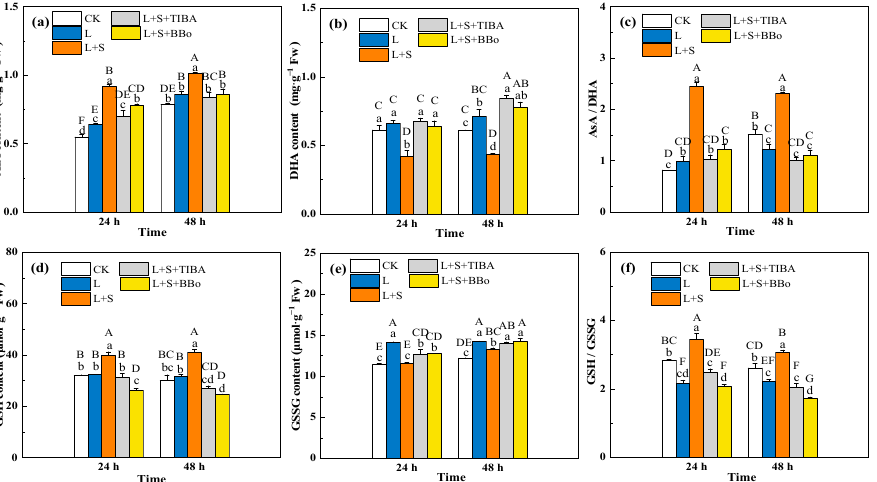
Figure 7. Effects of exogenous sucrose and IAA inhibitors on AsA ( a ), DHA ( b ), AsA/DHA ratio ( c ), GSH ( d ), GSSG ( e ), and GSH/GSSG ratio ( f ) of M. baccata under sub-low temperature. Bars indicate means ± standard error ( n = 3). The lowercase letters represent significant differences between treatments ( p < 0.05). The capital letters represent significant differences between full data ( p < 0.05). The comparison of means is based on the Duncan’s multiple range test. CK, control treatment; L, sub-low root-zone temperature (5 °C); L + S, 5 °C + 90 mmol·L − 1 sucrose; L + S + TIBA, 5 °C + 90 mmol·L − 1 sucrose + 500 μ mol·L − 1 2,3,5-triiodobenzoic acid; L + S + BBo, 5 °C + 90 mmol·L − 1 sucrose + 300 μ mol·L − 1 4-biphenylboronic acid. (See Supplementary Materials).